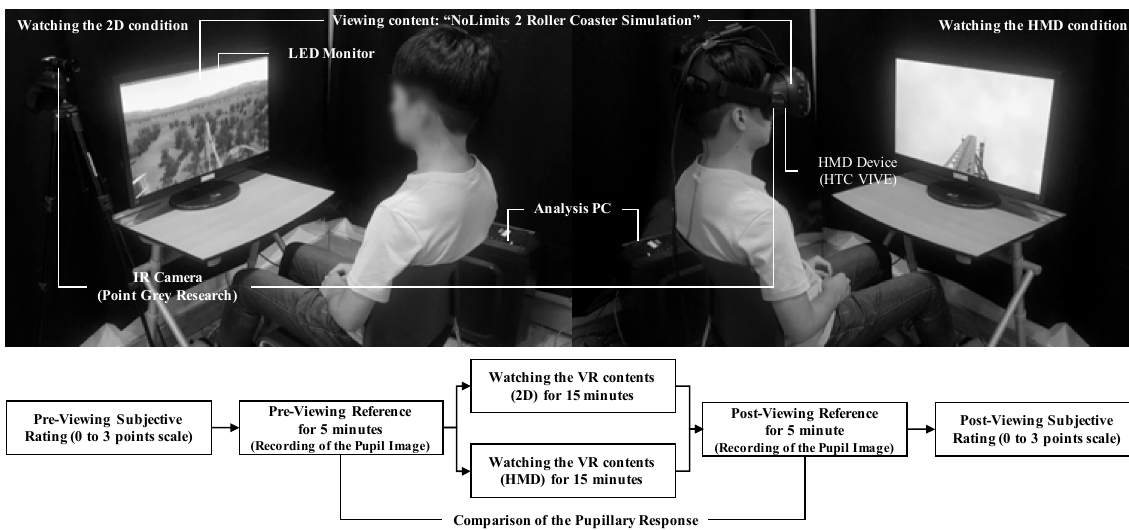
Figure 1. The experimental procedure and